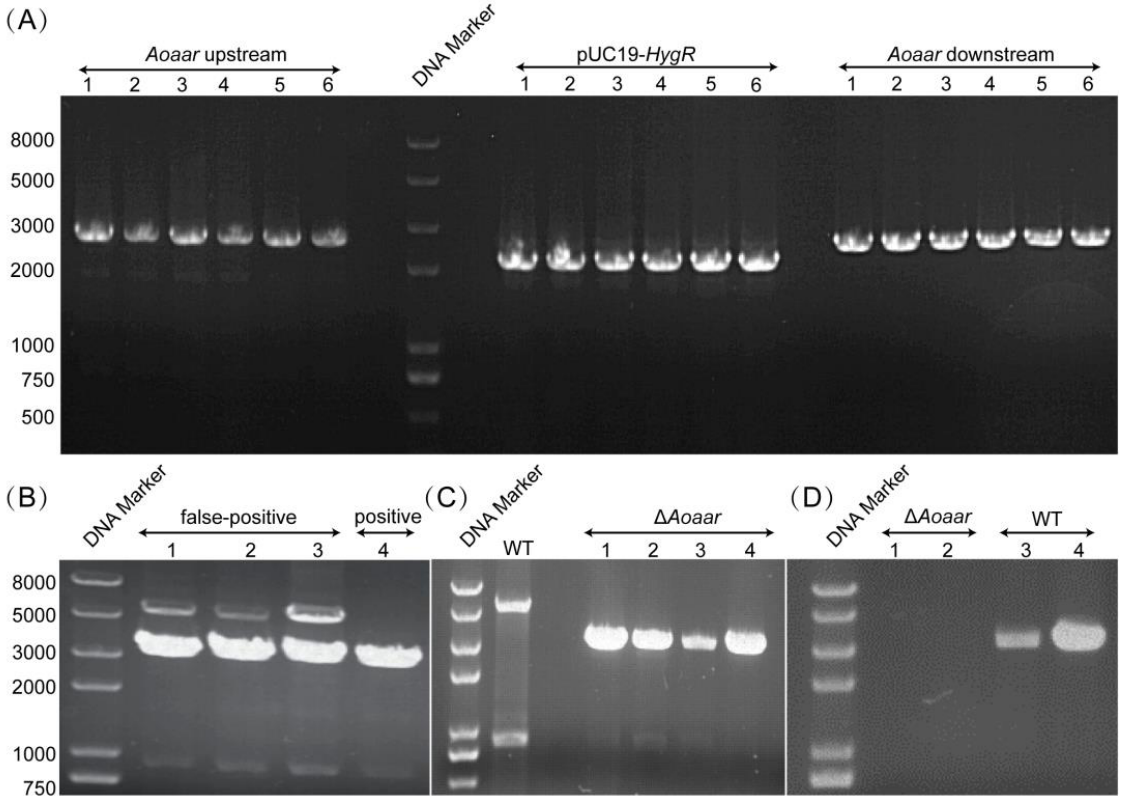
Figure 2. Screening and verification of Δ Aoaar mutant strain. ( A ) Verification of the PCR amplification of the Aoaar upstream homologous arm (2500 bp), downstream homologous arm (2500 bp), and hygromycin resistance gene expression cassette (2121 bp); ( B ) Verification of the Δ Aoaar mutant strain using diagnostic PCR, showing only the predicted 3145 bp of the amplicon. As a comparison, both the 3145 bp and 5438 bp fragments were generated for false-positive transformants; ( C ) Verification of four positive Δ Aoaar mutant strains, and the WT strain that was used as control; ( D ) RT-PCR verification: the WT strain has a target band (4299 bp), and the Δ Aoaar mutant strain has no target band via RT-PCR.